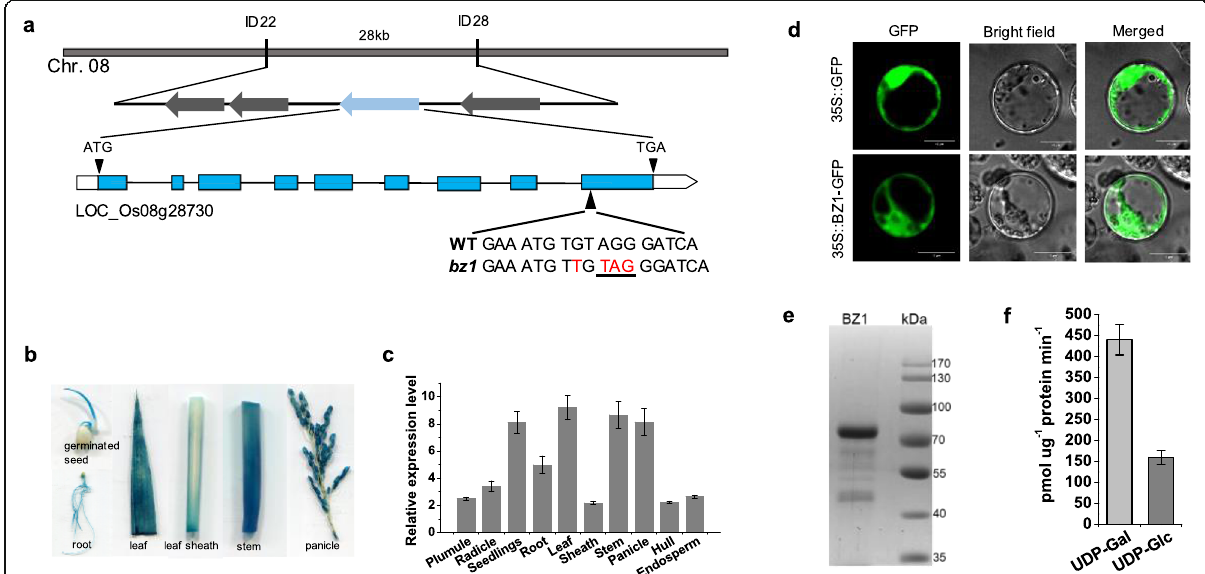
Fig. 2 Molecular and biochemical identification of BZ1 . a Map-based cloning of BZ1 . The arrows indicate the candidate genes. The boxes and lines in the diagram of the BZ1 gene indicate exons and introns, respectively. The arrowhead indicates a single base pair insertion (shown in a red-letter) in the last exon inducing a premature translational stop codon (underlined). b GUS activity staining assay in various organs of BZ1pro::GUS transgenic plants. c The expression pattern of BZ1 detected by qRT-PCR. d Observation of BZ1-GFP in rice protoplast. Scale bar, 10 μ m. e SDS/PAGE analysis of recombinant OsBZ1 expressed and purified from E. coli . Protein molecular mass standards (in KDa) are indicated on the right. The molecular mass of recombinant BZ1 is larger than the native BZ1 (due to the N-terminal GST tag fusion that facilitates purification). f UDP-Gal and UDP-Glc substrate specificity of recombinant purified BZ1. The error bar indicates SD values ( n =